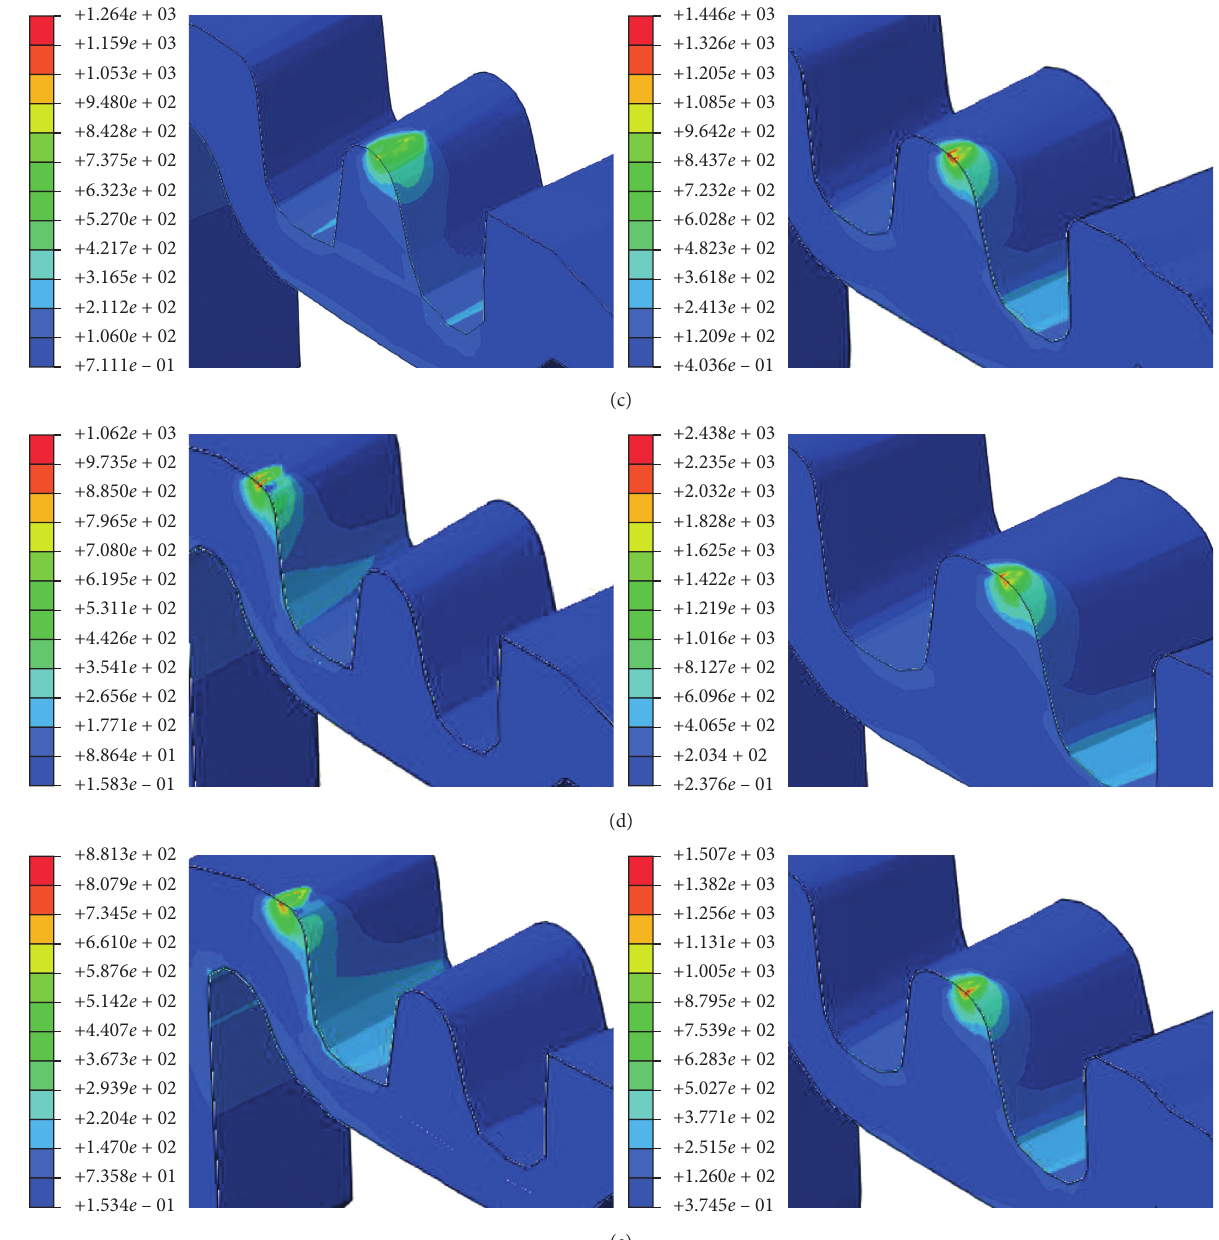
Figure 11: von Mises stresses of wheel-rail contact (the above for Section D and the below for Section E). (a) Wheel nominal profile. (b) Wheel profile I. (c) Wheel profile II. (d) Wheel profile III. (e) Wheel profile